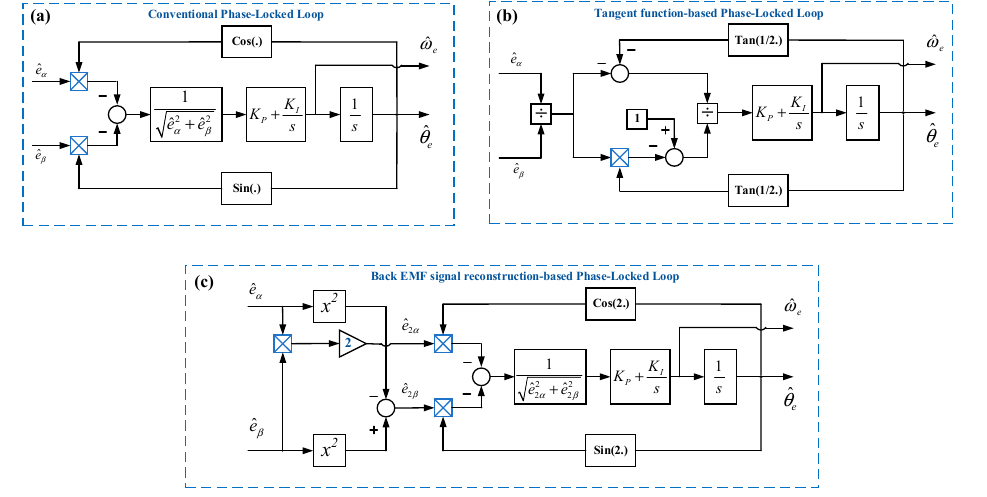
Figure 2. The structures of the PLL (phase-locked loop).